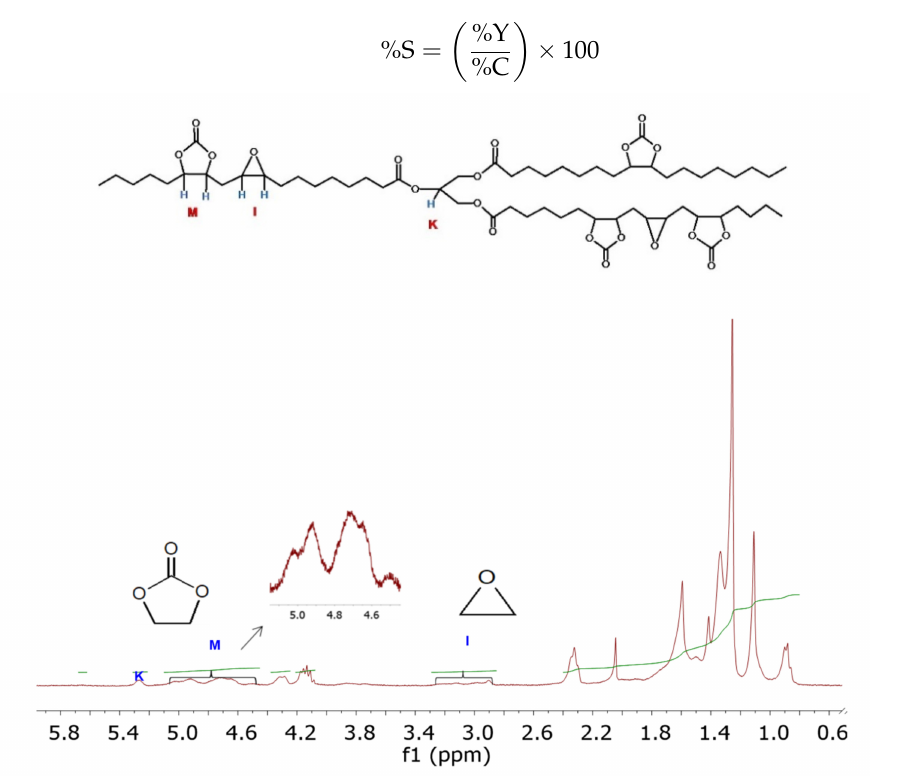
Figure 4. Values obtained by 1 H-NMR in the carbonation reaction at 90 ◦ C, 60 psi, 3.5% TBAB, and 68